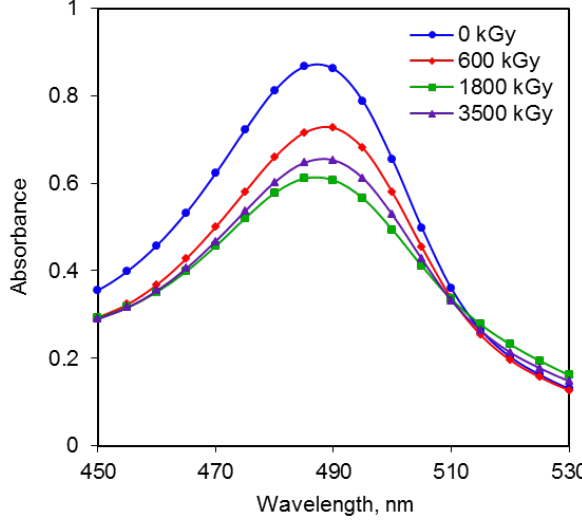
Figure 1. Absorbance of total sugars for control and irradiated